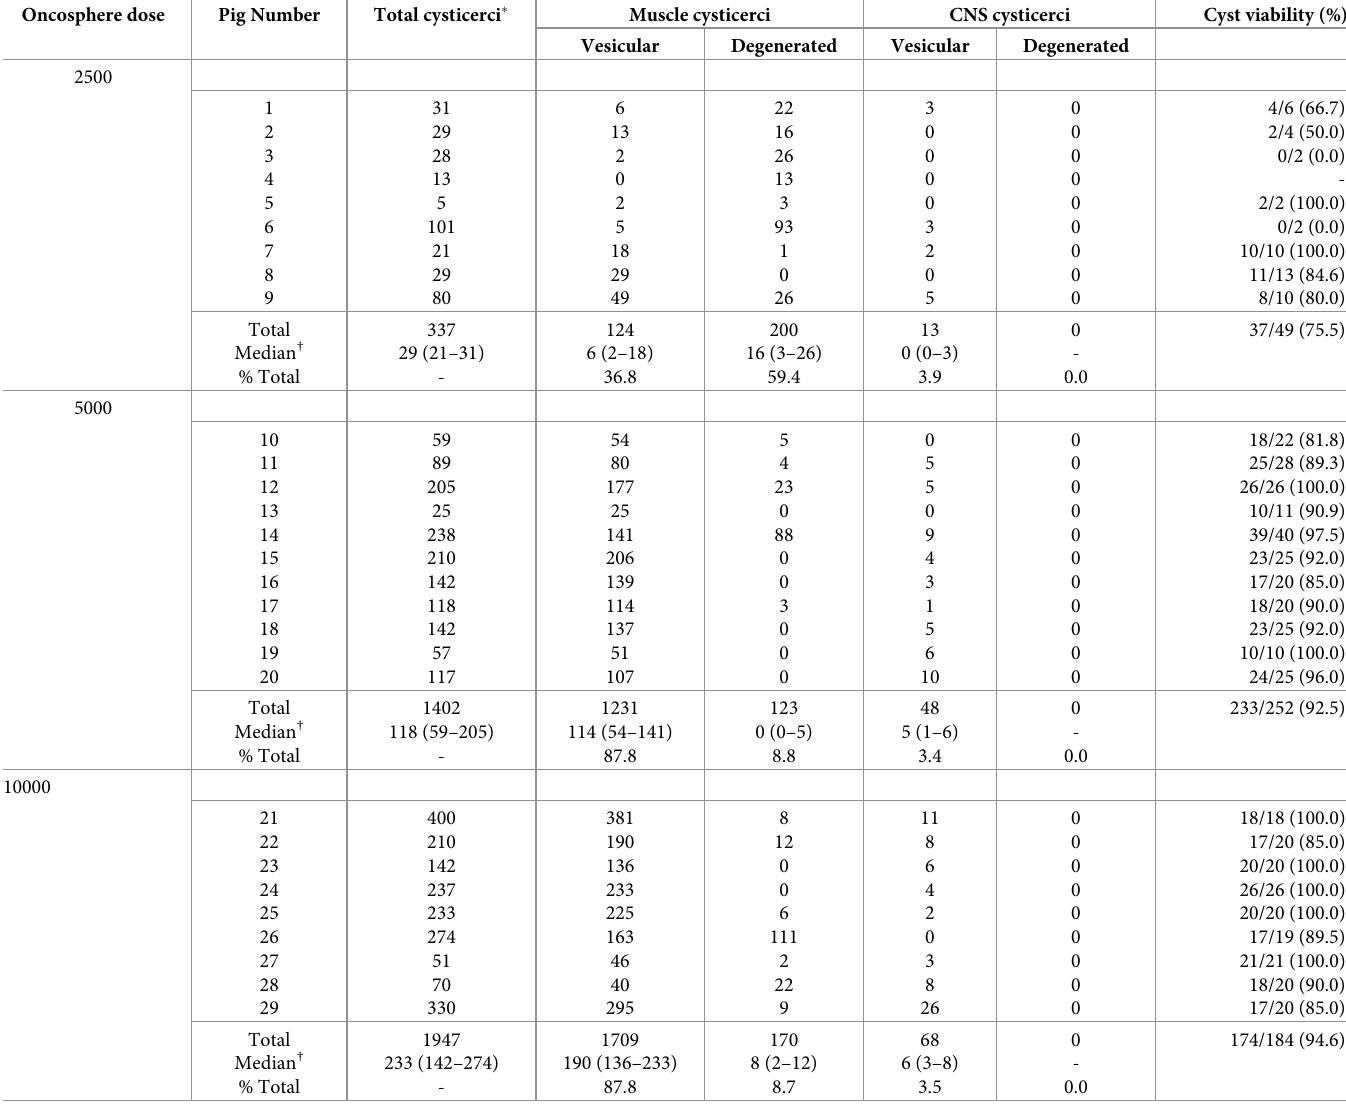
Table 2. Necropsy results (cyst burden with either vesicular or degenerated cysticerci in muscle and CNS) and percentages of cyst viability in pigs according to onco- sphere dose-groups. Oncosphere dose Pig